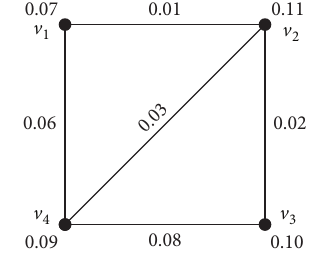
Figure 1: A fuzzy labeling graph.